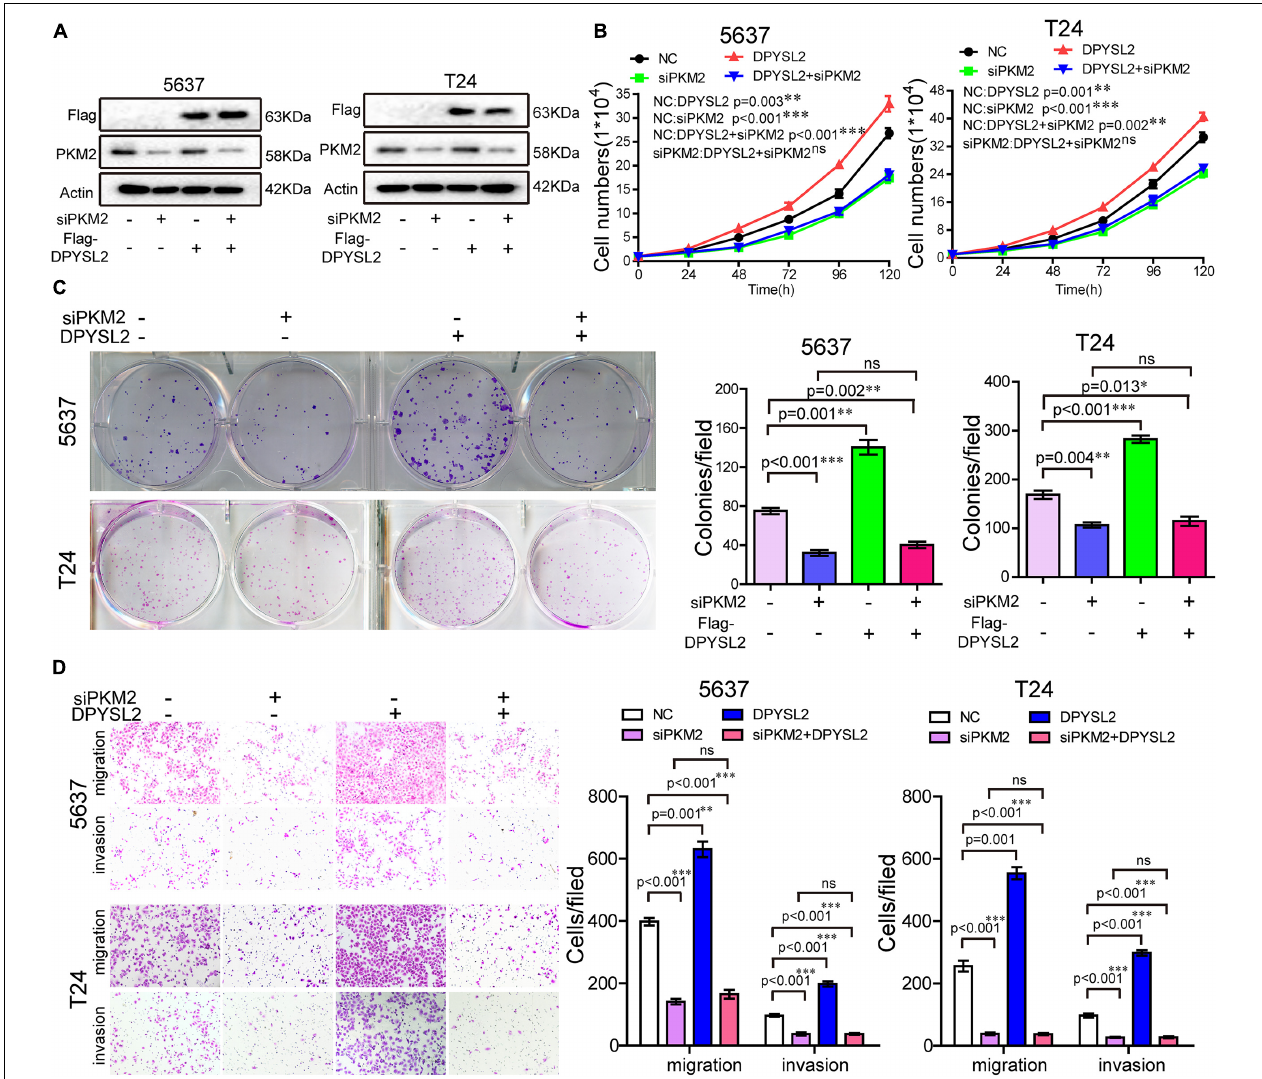
FIGURE 5 | Pyruvate kinase M2 (PKM2) silencing completely abolished DPYSL2-enhanced malignant behaviors of bladder cancer cells. Stable Flag-DPYSL2-overexpressing 5637 or T24 cells were transfected with siPKM2 or negative control. The protein levels of Flag-DPYSL2 and PKM2 (A) , cell proliferation (B) , colony formation (C) , migration, and invasion (D) were examined. Data are expressed as the mean ± SEM. * P < 0.05, ** P < 0.01, *** P < 0.001; ns, non-significant; n =